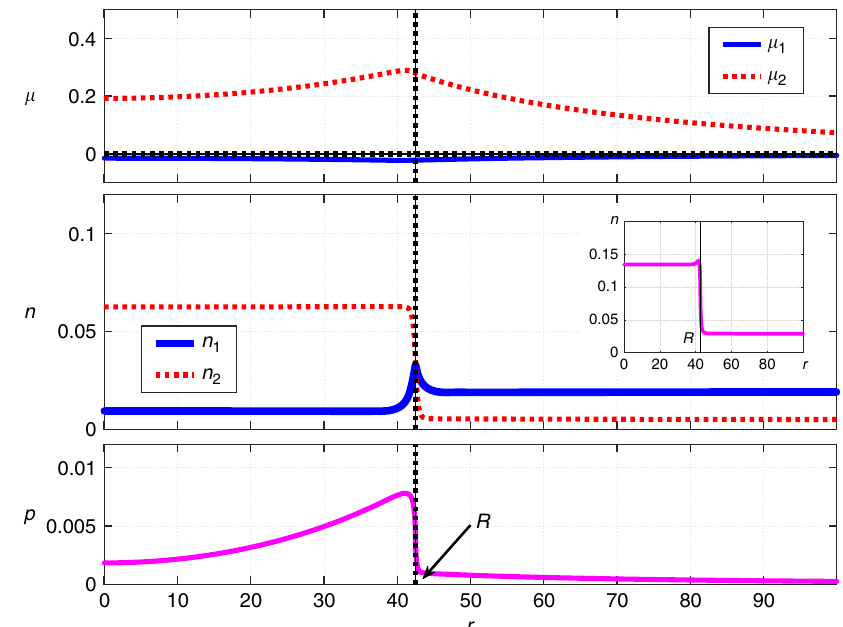
Fig. 7 Stationary droplet solution, 2nd order reaction case. Shown are the radial-coordinate dependences of the chemical potentials μ i ( i = 1, 2), concentrations n i ( i = 1, 2), and pressure p for a stationary, spherically symmetric cluster of radius R , as obtained by solving the reaction-diffusion scheme in Eq. (2). The inset shows the r -dependence of the total amount of the solute, n (cid:4) n 1 þ 2 n 2 . The following parameter values are employed: κ ð d